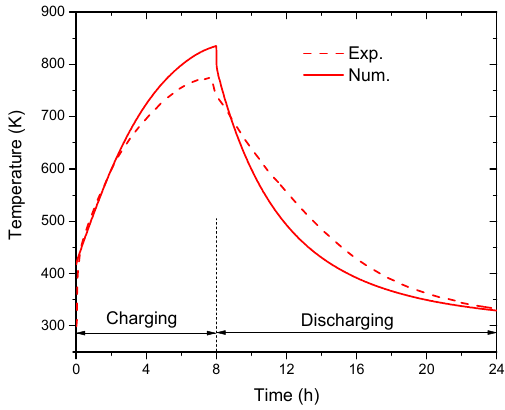
Figure 3. The evolution of the air temperature at the outlet of the experimental (Exp.) and numerical (Num.) results.